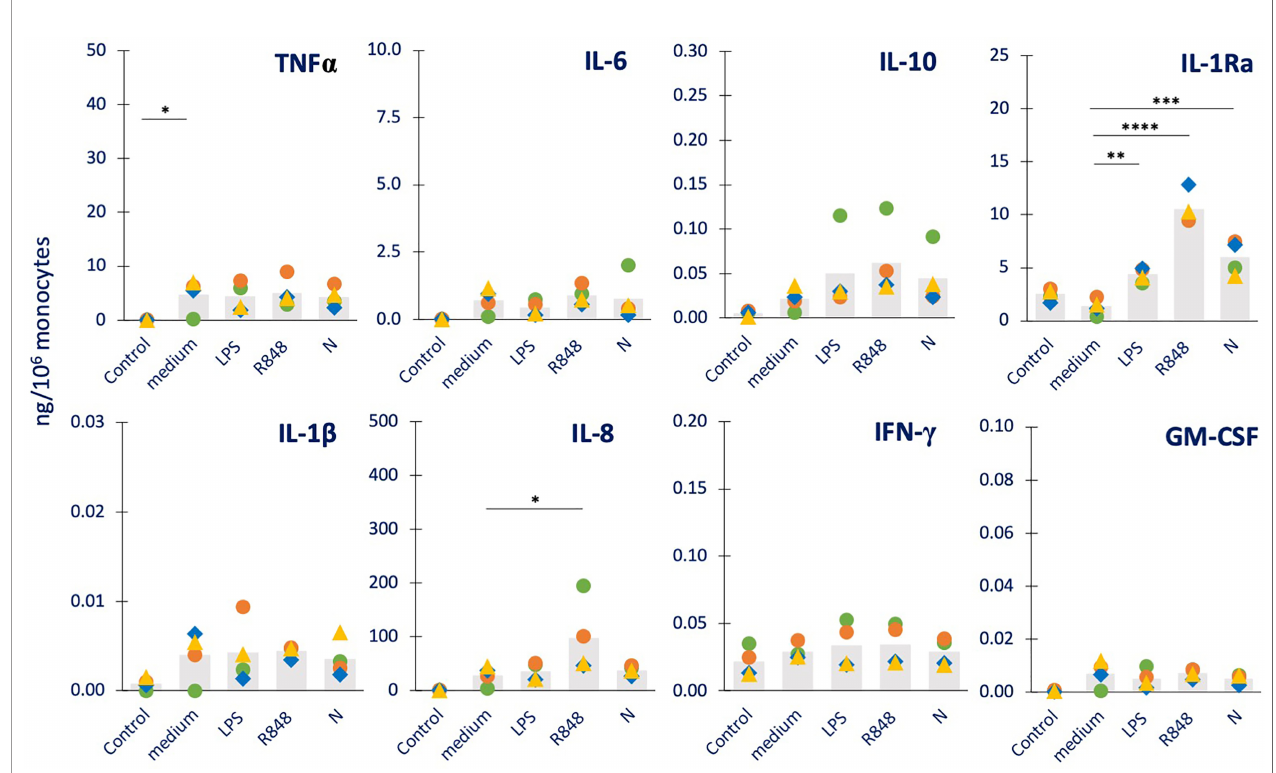
FIGURE 4 | Innate immune memory response to a challenge with the N protein in human monocytes primed with bacterial or viral agents. Human monocytes isolated from blood of four individual donors (green, red, blue, and yellow symbols) were cultured for 24 h in culture medium alone (column “ medium ” ) or containing LPS (1 ng/mL, column “ LPS ” , control bacterial agent), R848 (0.5 µg/mL, column “ R848 ” , control virus-like agent) or N (1 µg/mL, column “ N ” ). Cells were then washed and rested for 7 days in the absence of stimuli, then challenged for 24 h in fresh medium alone or containing 5 µg/mL N. The production of TNF a , IL-6, IL- 10, IL-1Ra (upper panel from right to left) and IL-1 b , IL-8, IFN- g , GM-CSF (lower panel from right to left) was measured in the 24 h supernatants by ELISA. The values from cells that received no challenge are included in each panel as “ Control ” and encompass the values obtained from primed and unprimed cells (which did not differ, con fi rming the return to baseline after the resting period). Data are presented as individual donors ’ values (colored symbols) and as mean of the individual values (gray columns). Statistical signi fi cance: * p < 0.05; ** p < 0.01; *** p < 0.001; **** p <